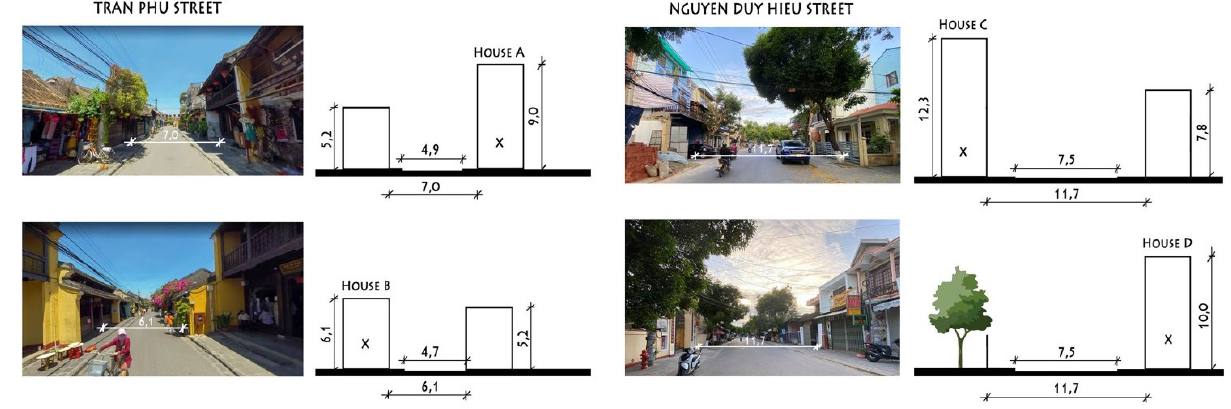
Figure 6. Cross-section of Tran Phu Street and Nguyen Duy Hieu